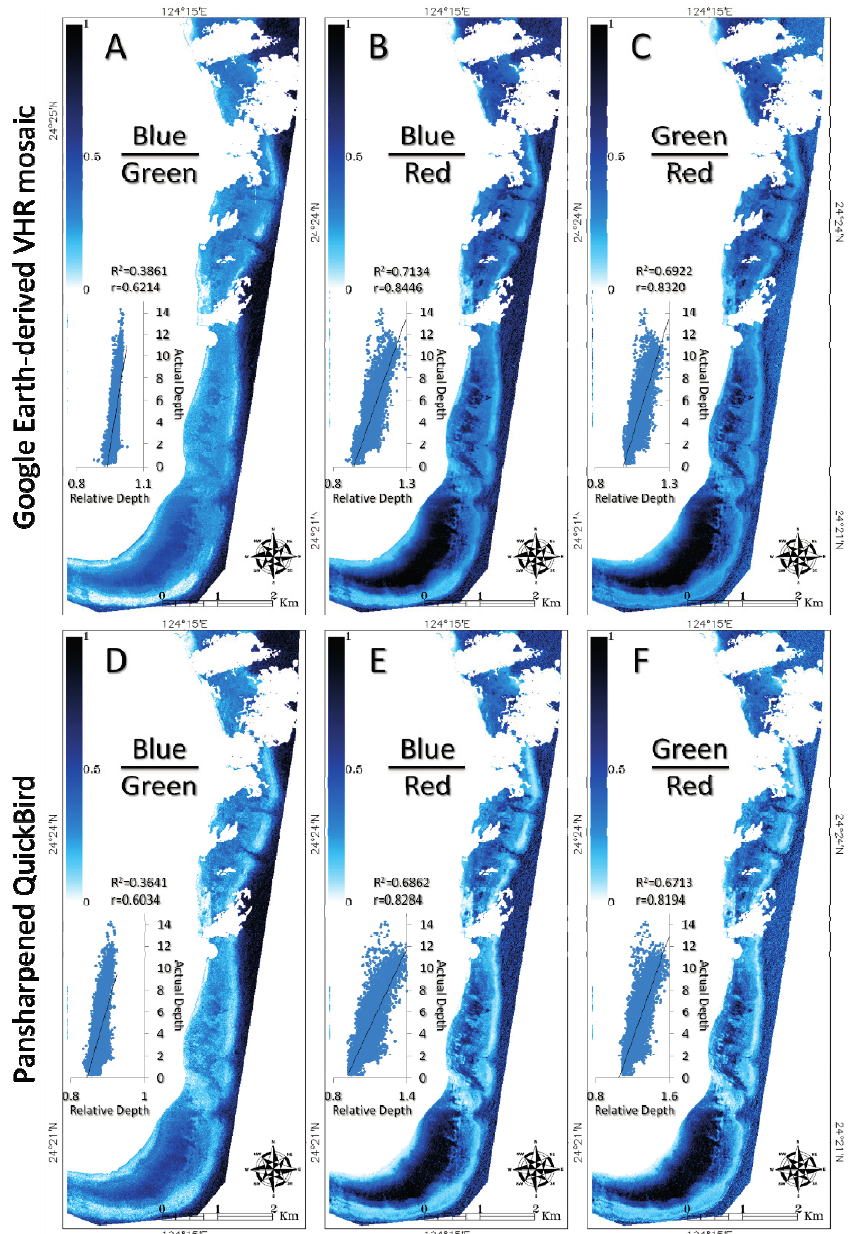
Figure 6. Digital Relative Depth Models (DRDM) resulting from the ratio transform based on blue-green, blue-red and green-red spectral bands derived from ( A , B and C , respectively) Google Earth-derived very high resolution mosaic imagery and ( D , E and F , respectively) pansharpened QuickBird imagery. Scatterplots comparing the relative and actual depths as well as the linear coefficient of determination ( R 2 ) and Pearson product-moment correlation coefficient ( r ) are embedded for each